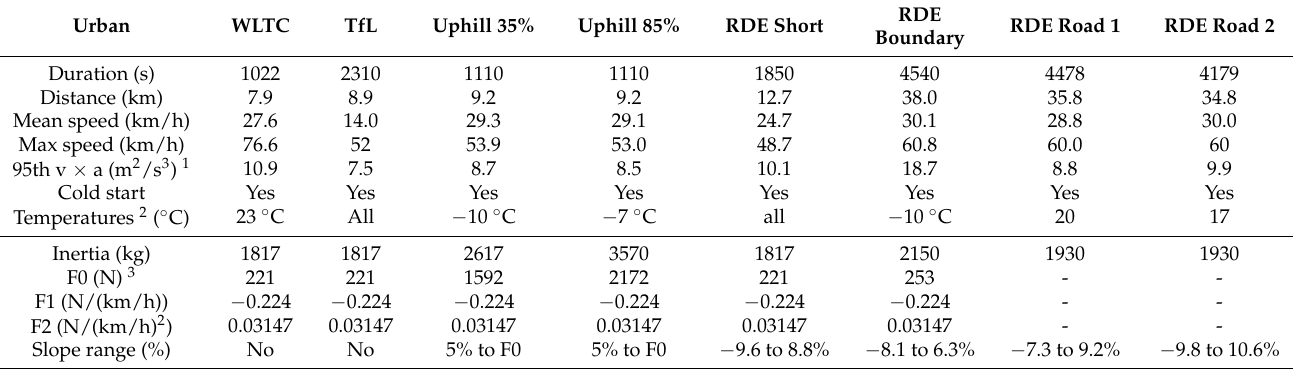
Table 2. Characteristics of the urban cycles (TfL, uphill) and the urban parts of the RDE tests and the WLTC (low and medium phases). All tests conducted on the chassis dynamometer except RDE Road 1 and 2 which were done on the road.